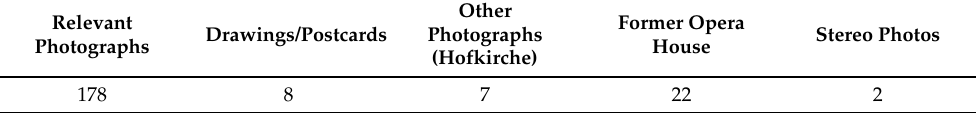
Table 2. Table showing the distribution of final results for the Semperoper yielded by LEA. LEA also yields images of the Hofkirche, which is situated across the Semperoper. These images are also tagged in the metadata via the Semperoper keyword but are not meant to be used for its